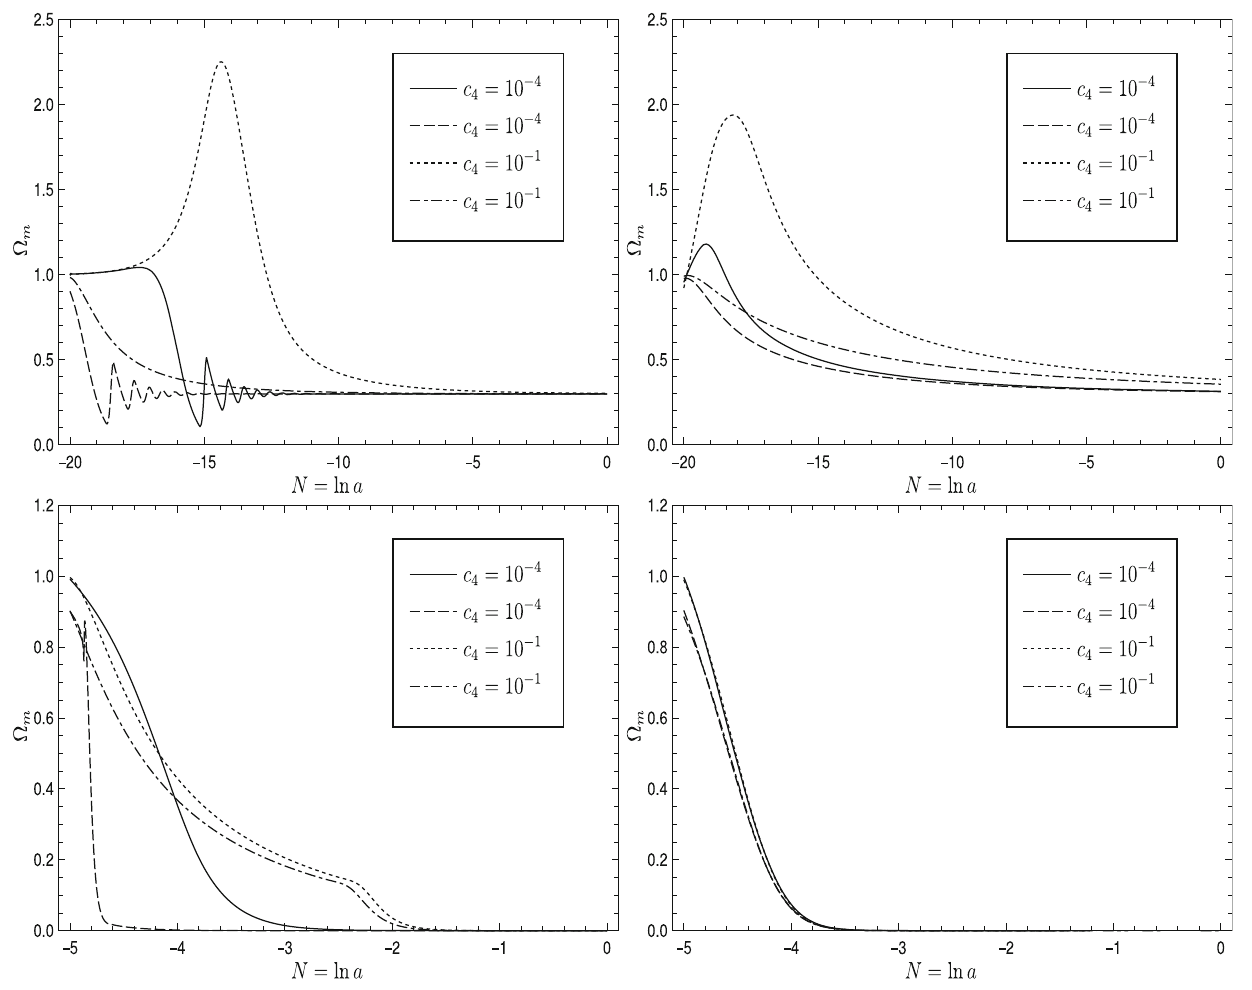
Fig. 2 Plots of (cid:10) m as a function of N . The upper two panels represent the cases x r > 0 during the matter domination, while the lower two panels represent the cases x r < 0 during the matter domination. The